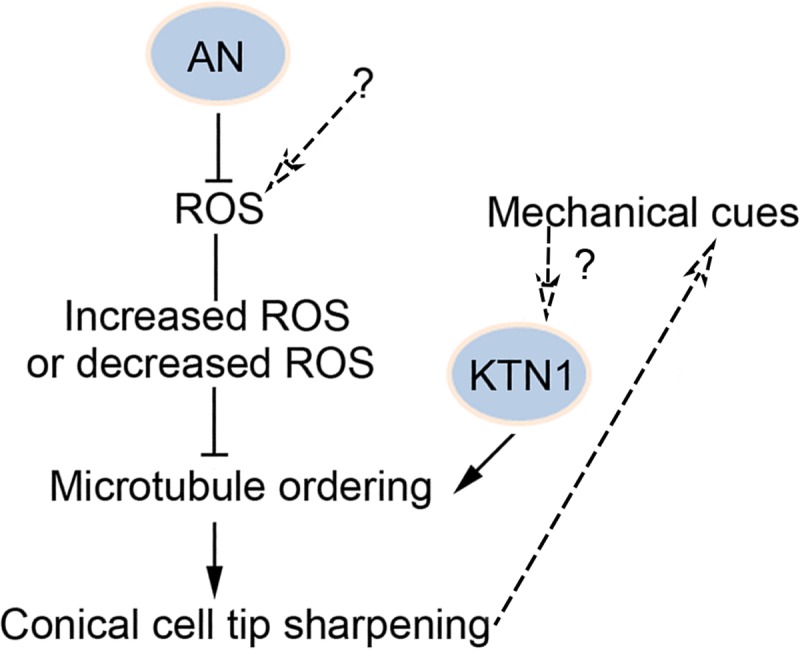
Proposed model of ROS-dependent regulation of microtubule orientation and conical cell tip sharpening.A model depicting the molecular basis of ROS-dependent microtubule orientation and conical cell tip sharpening. We propose that AN and KTN1 jointly function to modulate microtubule orientation and conical cell shaping. AN functions to suppress ROS production, respectively. Both increased and decreased ROS suppress microtubule orientation into well-ordered circumferential arrays. We hypothesized that mechanical forces could generate a signal to induce microtubule orientation, and that conical cells could respond to mechanical cues generated by cell geometry, providing a feedback loop.